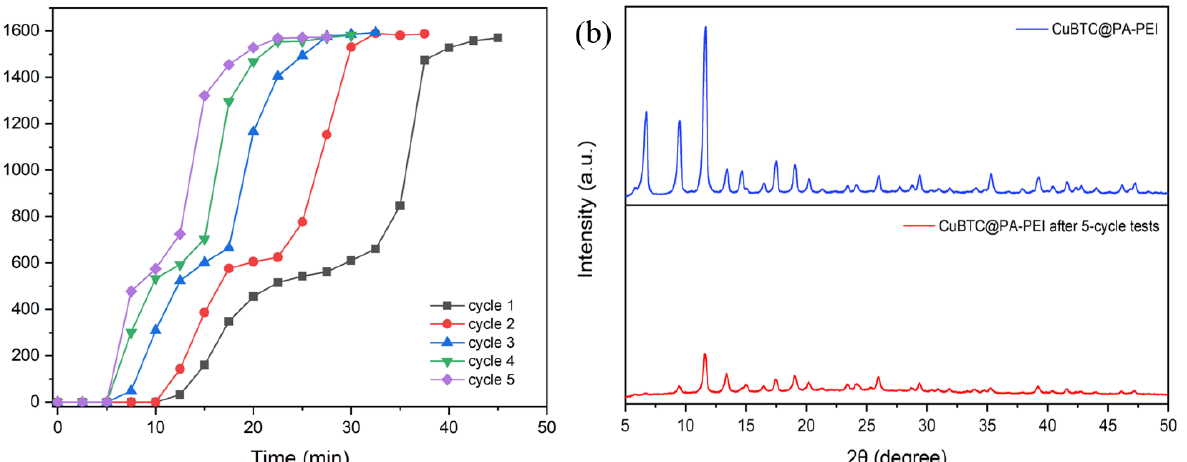
Table 3. Breakthrough time comparison of other materials reported in the literature.